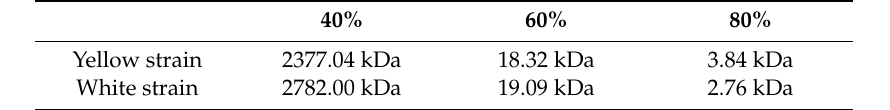
Table 2. The weight average molecular weight of ( a ) yellow strain and ( b ) white strain polysaccharides by fractional precipitation.